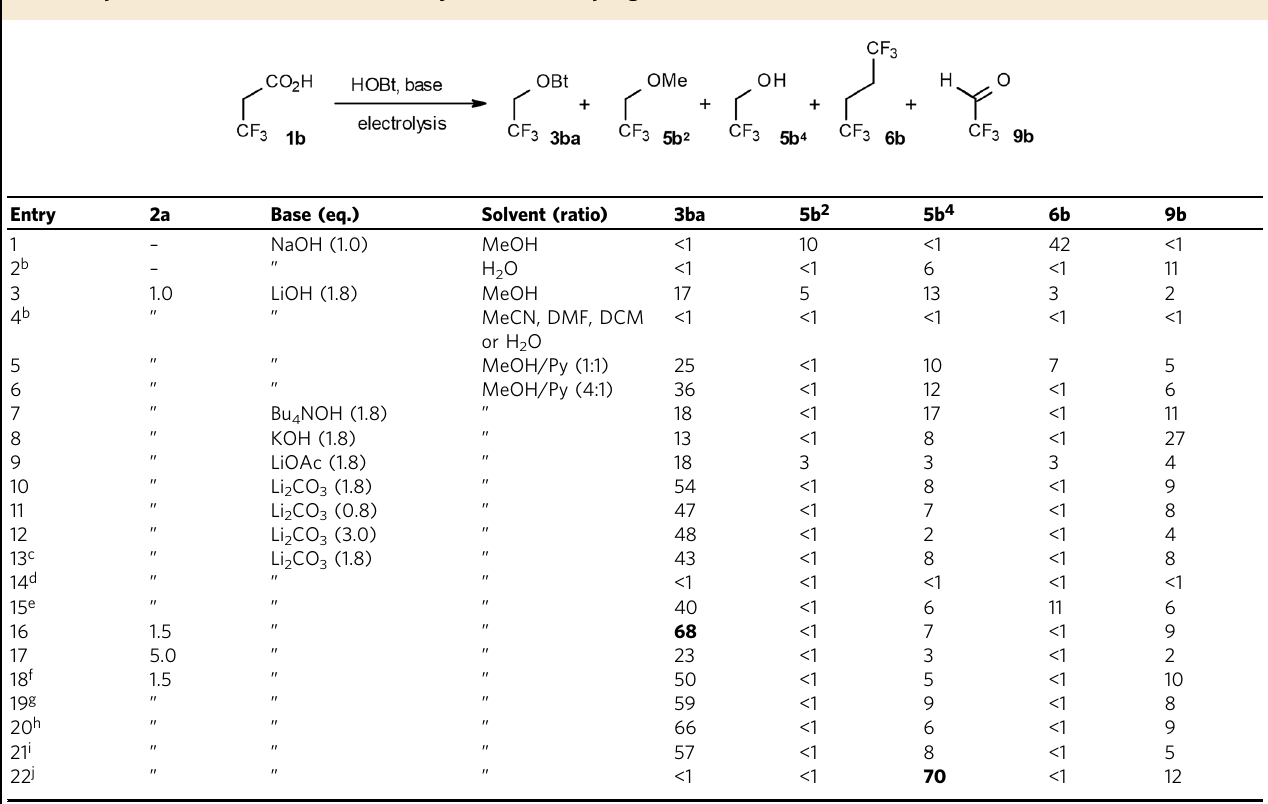
Bold font indicates optimal conditions. a Reaction conditions: 1.0mol of TFPA 1b , HOBt·H 2 O 2a , base, Pt( + )/Pt( – ) (2.0cm 2 ), undivided cell, 500mA for 30min (9.33Fmol – 1 ), 12ml solvent, r.t., 30min. Yields determined by 19 F NMR using (tri fl uoromethoxy) benzene as the internal standard. b >70% of 1b . c Carbon